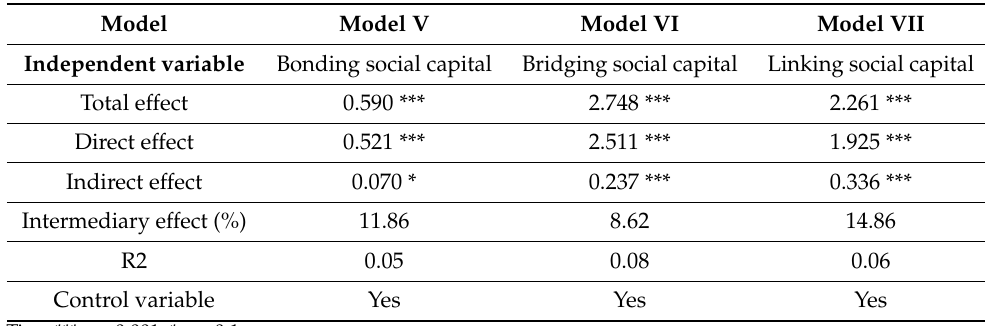
Table 7. KHB test results of the psychological capital mediation